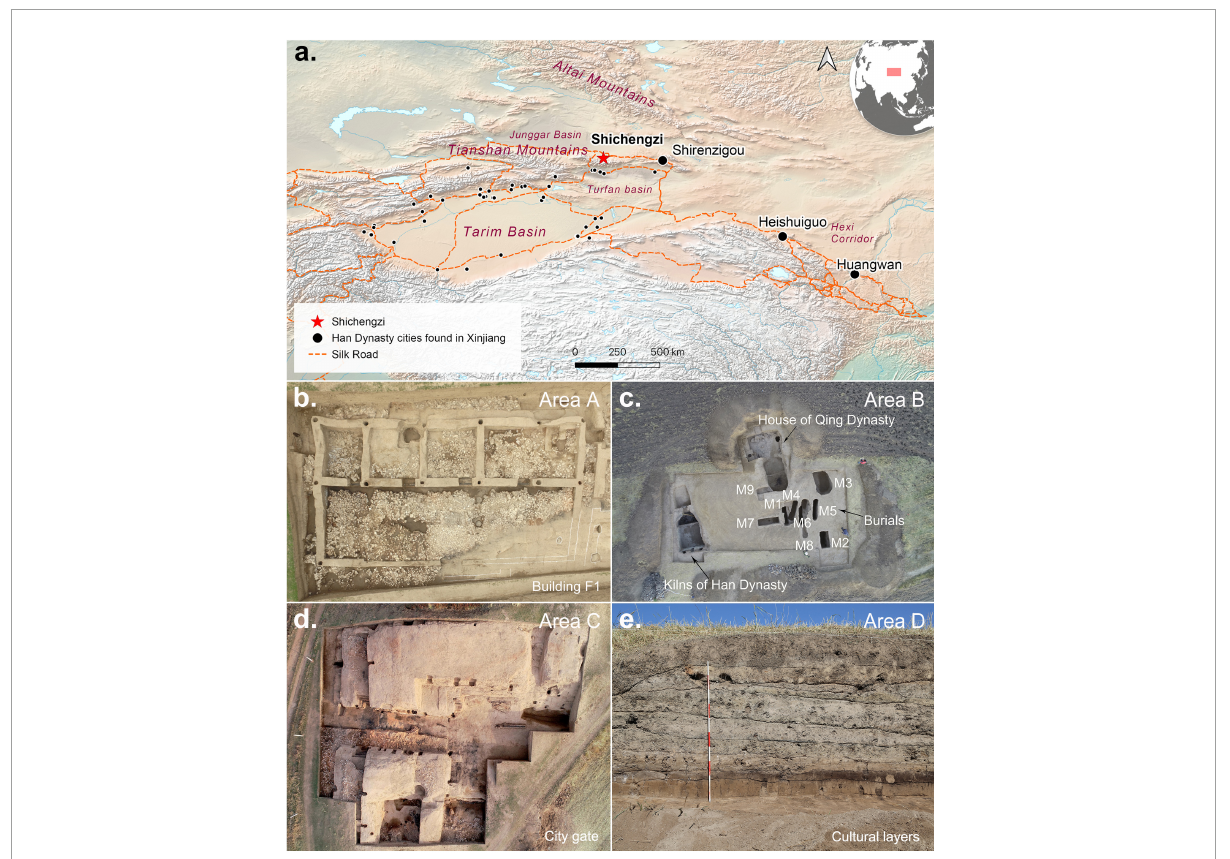
FIGURE1 (a) Map of northwestern China. Small dots represent Han cities found in Xinjiang. (b–e) Main findings at Areas A–D at the Shichengzi